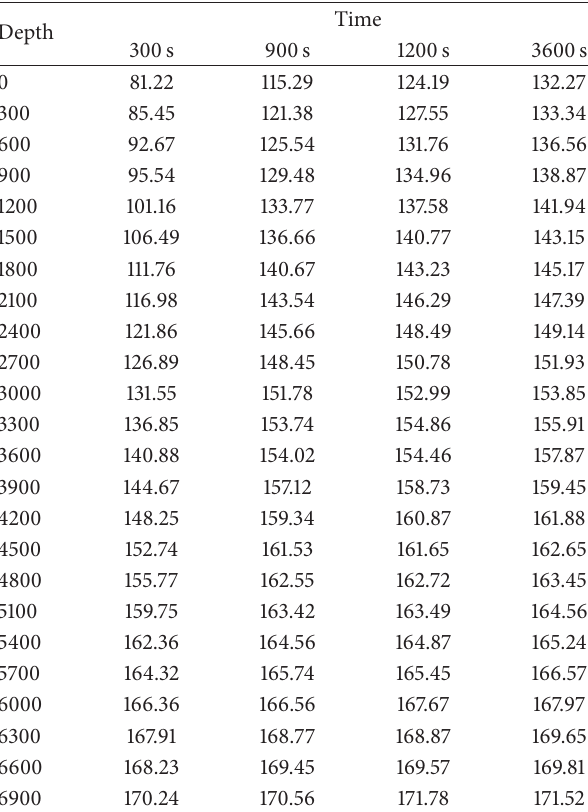
Table 4: Pressure at different depths on 300 s, 900s, 1200 s, and 3600 s.